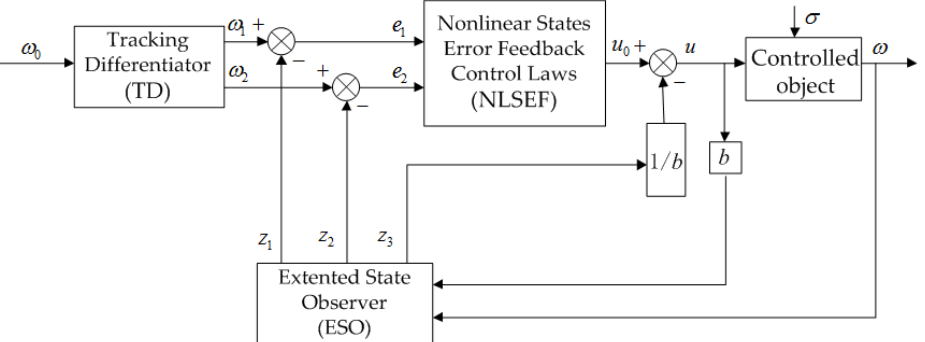
Figure 12. Structure of the active disturbance rejection controller.